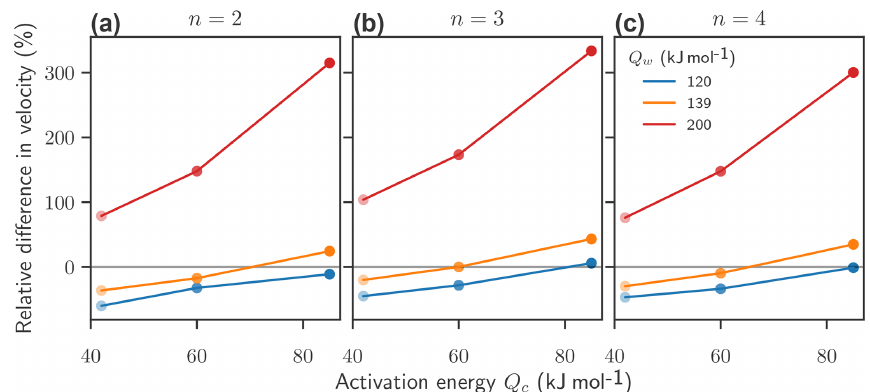
Figure 10. Effect of the flow exponent and activation energies on mean velocity change after 100 years under 2 ◦ C of warming: relative difference in average surface velocity f or n = 2 (a) , n = 3 (b) , and n = 4 (c) for different combinations of the flow exponent n and activation energies Q c and Q w . The reference is always a simulation performed with standard parameters n = 3, Q c = 60kJmol − 1 , and Q w = 139kJmol − 1 . Variations in the flow exponent n do not significantly influence the relative difference of mean velocities after 100 years.